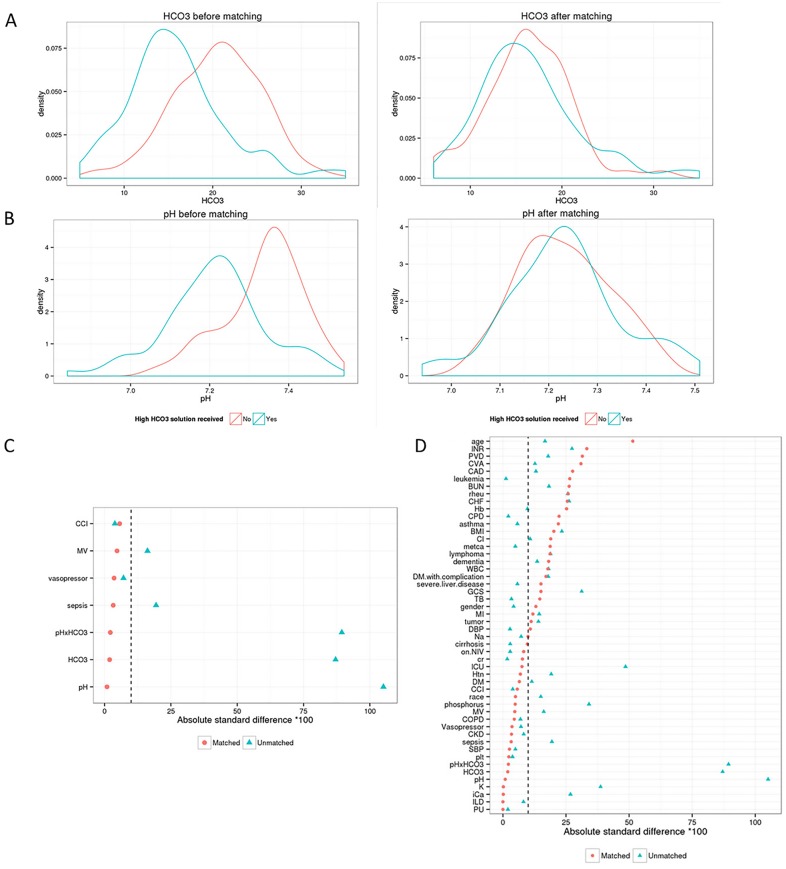
Distribution of A) Bicarbonate and B) pH before and after propensity matching. C) Absolute standardized difference plot for variables identified as most important for matching. D) Absolute standardized difference scheme for all variables in the dataset. Abbreviations: CCI, Charlson Comorbidity Index; MV, Mechanical Ventilation; INR, International Normalized Ratio; PVD, Peripheral Vascular Disease; CVA, Cerebrovascular Accident; CAD, Coronary Artery Disease; BUN, Blood Urea Nitrogen; Rheu, History of Rheumatologic Diseases; CHF, Congestive Heart Failure; Hb, Hemoglobin; CPD, Chronic Pulmonary Disease; BMI, Body Mass Index; Cl, Chloride; metca, Metastatic Cancer; WBC, White Blood Cell; DM, Diabetes Mellitus; GCS, Glasgow Coma Scale; TB, Total Bilirubin; MI, Myocardial Infarction; DBP, Diastolic Blood Pressure; NIV, Non-Invasive Ventilation; ICU, Intensive Care Unit; Htn, Hypertension; COPD, Chronic Obstructive Lung Disease; CKD, Chronic Kidney Disease; SBP, Systolic Blood Pressure; ILD, Interstitial Lung Disease; PU, Peptic Ulcer.